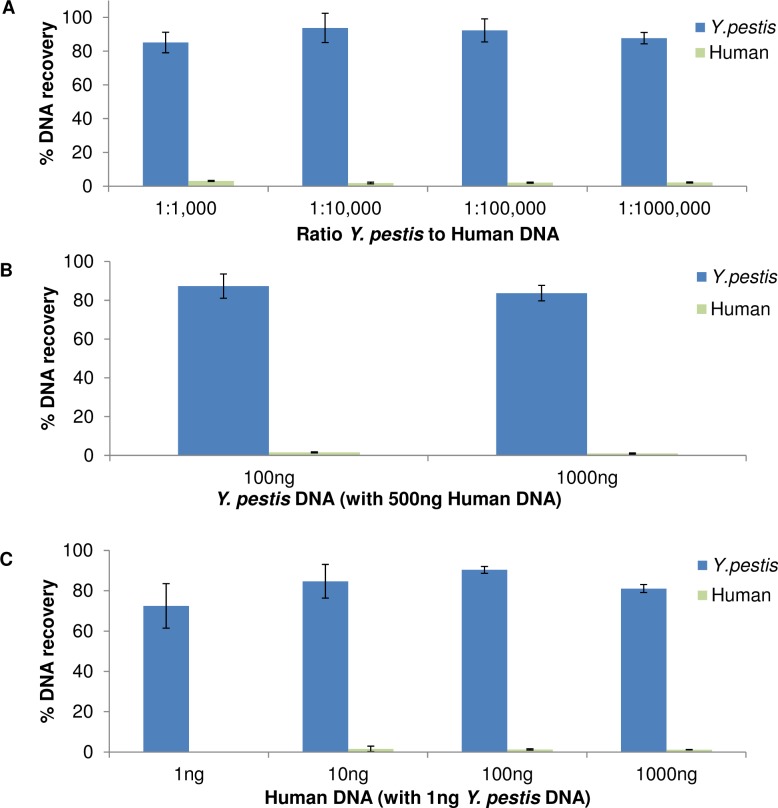
Y. pestis genomic DNA is efficiently segregated from human DNA.(A) Recovery of decreasing levels of Y. pestis DNA (blue bars) from a fixed 1000 ng human DNA (green bars). (B) DNA recovery using 100 ng and 1000 ng Y. pestis DNA in a background of 1000 ng human DNA. (C) Recovery of a fixed 1 ng of Y. pestis DNA (blue bars) from increasing levels of human DNA (green bars).